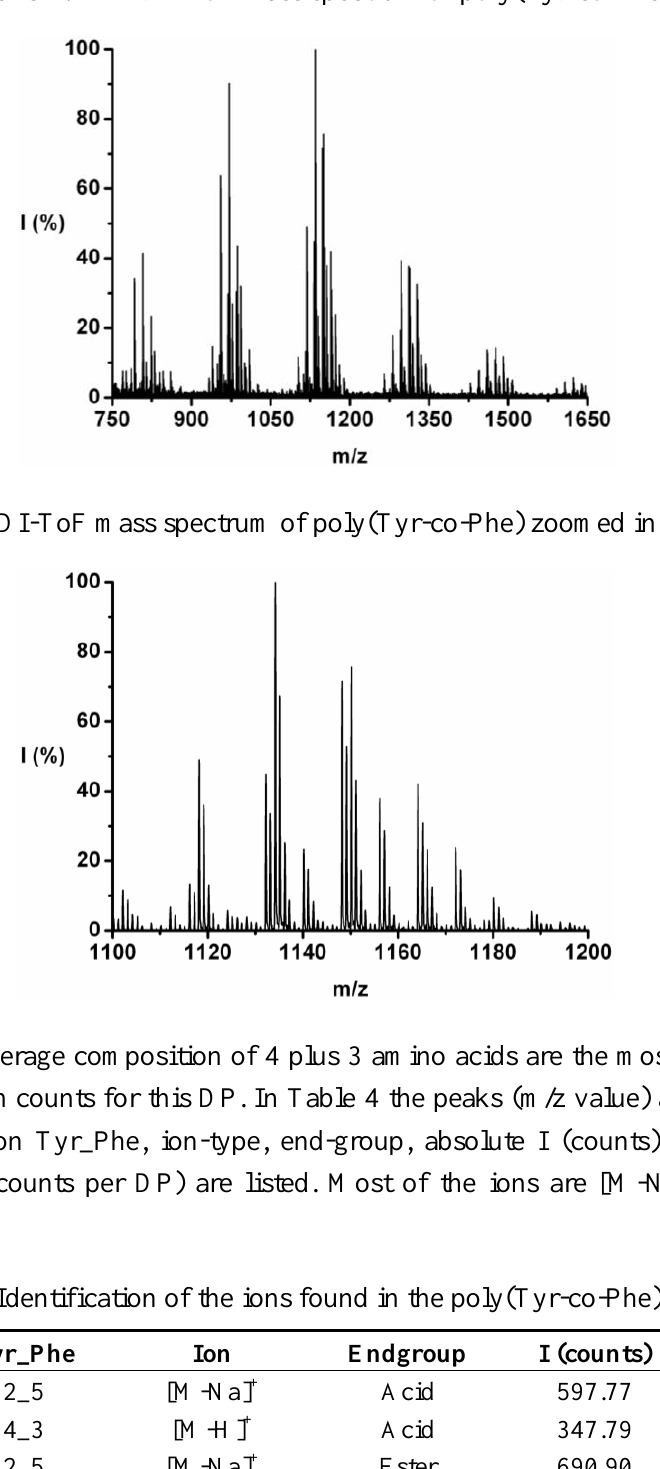
Figure 2. MALDI-ToF mass spectrum of poly(Tyr-co-Phe).